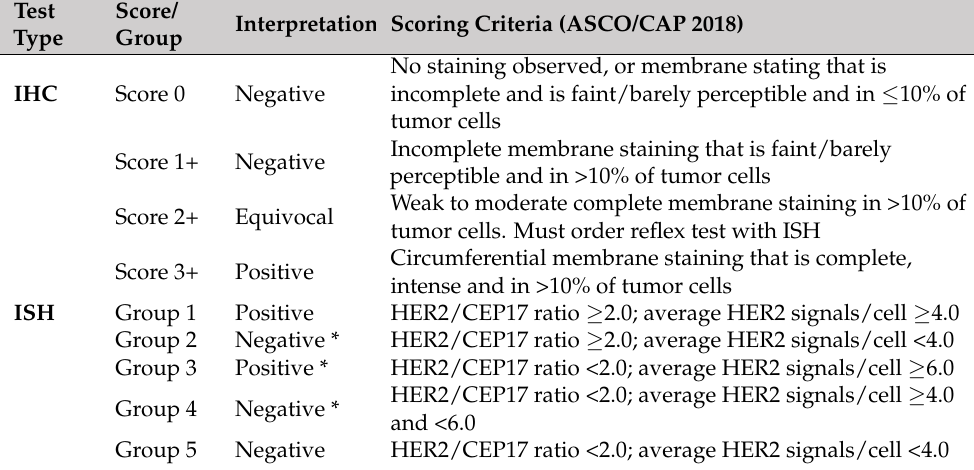
Table 2. HER2 Testing by Immunohistochemistry (IHC) and Dual-probe ISH